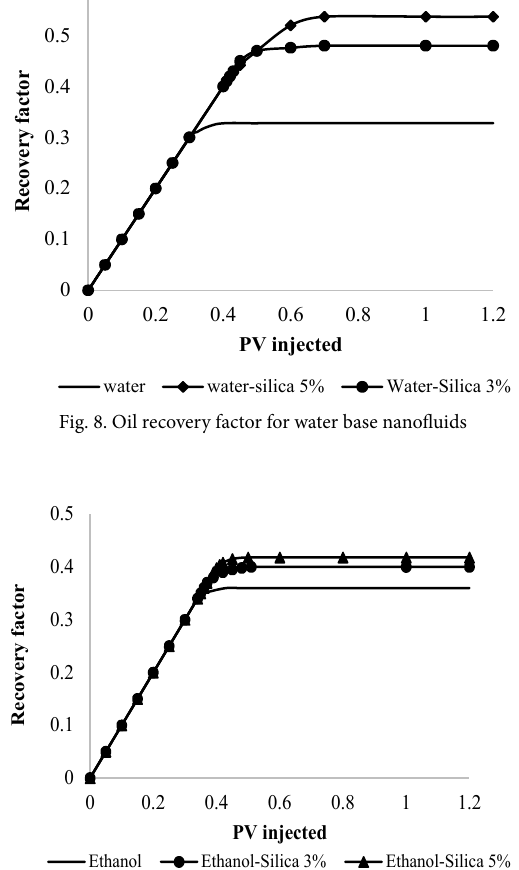
Fig. 11. Oil recovery factor for gas condensate base